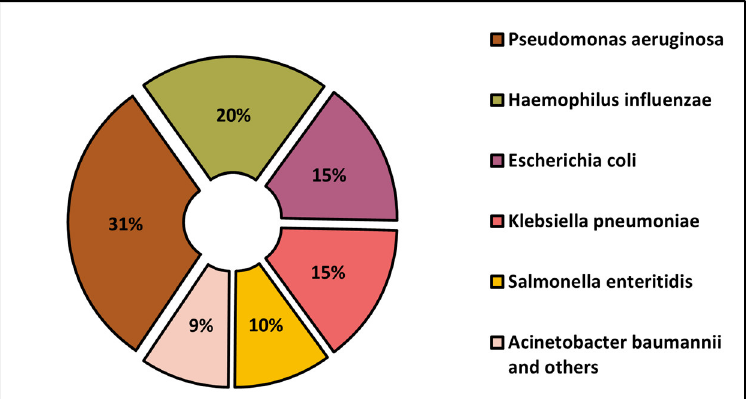
Figure 2. The proportion of Gram-negative bacteria identified.